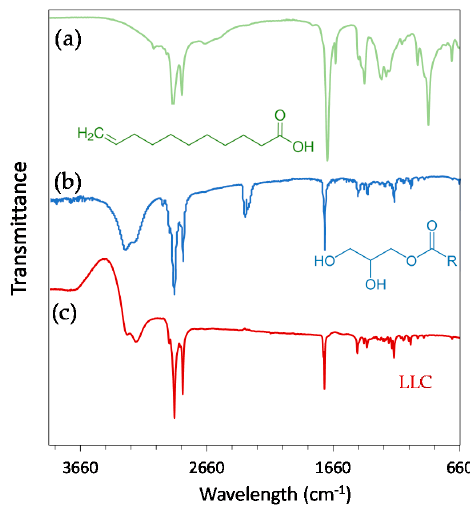
Figure 1. Fourier transform infrared (FTIR) spectra of ( a ) undecylenic acid; ( b ) Dimodan U/J (monoglycerides) and ( c ) lipid-based liquid crystals (LLC). The molecules corresponding to each FTIR spectrum have been added below.